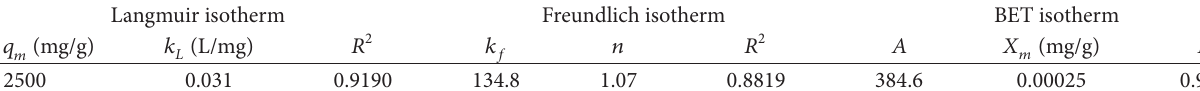
T 2: Isotherm parameters for adsorption of RR-120 onto SWCNTs at 23